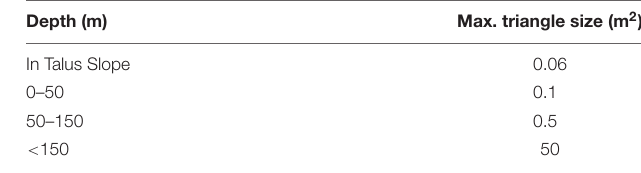
FIGURE 1 | (A) Talus slopes situated below steep rock walls in Hallingskarvet, southern Norway (60 ◦ 35 (cid:48) 47 (cid:48)(cid:48) N, 07 ◦ 40 (cid:48) 37 (cid:48)(cid:48) E). (B) The numerical domain represents a vertical 2D cross-section through the landscape in panel (A). From top to bottom, the geometry consists of a flat plateau, a steep rock wall (80 ◦ ) and a gentle talus slope (35 ◦ ). The black line indicates a virtual borehole illustrating the ground components as depicted. The solid line marks the boundary between the solid bedrock (98% mineral, 2% water) and the water-rich talus (40% mineral, 60% water/ice), while the dashed line marks the boundary between the water-rich talus and the blocky surface layer (40% mineral, 2% water, 58% air). The square marks the area for which ground temperature fields are presented in Figures 2 , 3 . The mesh resolution is presented for the areas within the two squares. (C) Ground surface temperature forcing through the simulation period for one point at the snow-covered talus surface and one point at the snow-free rock wall surface. The elevation distance between the points is 40